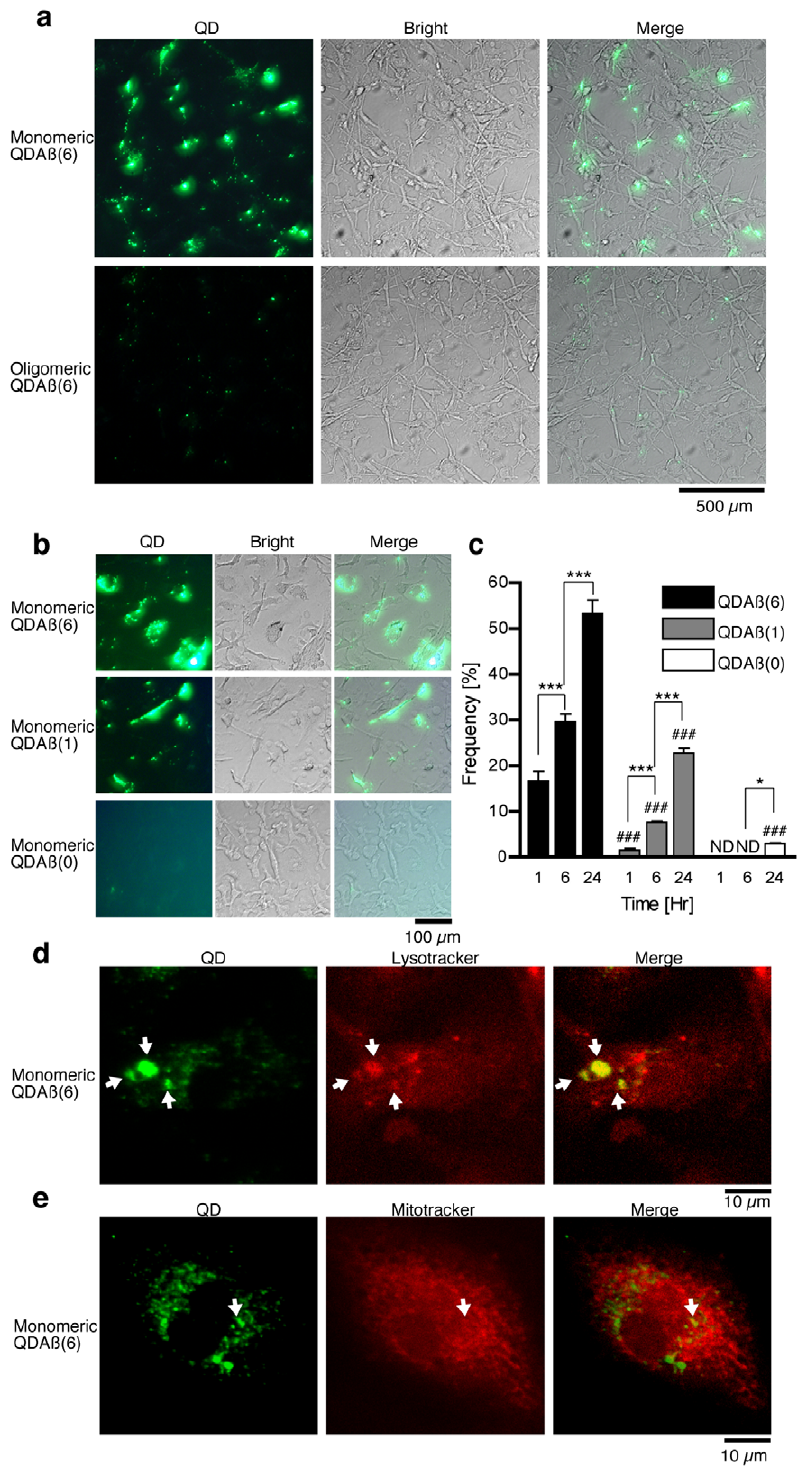
Figure 5. Imaging of QDA b in cultured microglia. (a) Mouse microglia were incubated with 50 nM monomeric (top) or oligomeric (bottom) QDA b (6) for 1 day, and observed by wide-field fluorescence microscopy using a 20x objective lens with FITC filter set. (b) Microglia were incubated with 50 nM monomeric QDA b (6) (top), QDA b (1) (middle), and QDA b (0) (bottom) for 1 day, and observed by wide-field fluorescence microscopy using a 20x objective lens with FITC filter set. (c) Time-dependent monomeric QDA b uptake by microglia. The number of cells with ingested QDA b shown as the average percentage of total microglia. Error bars indicate SD (n=3). ND: undetected. * and *** denote 0.01 , P , 0.05, and P , 0.001, respectively, vs. 6 h time point of the same QD group, and ### denotes P , 0.001 vs. the same time point of QDA b (6) samples. (d and e) Co- localization with Lysotracker (d) and Mitotracker (e). Microglia were incubated with 50 nM monomeric QDA b (6) for 1 day, and then labeled with Lysotracker or Mitotracker, followed by confocal microscopy. Arrows show co-localization of QD (green) and Lysotracker/Mitotracker (red).